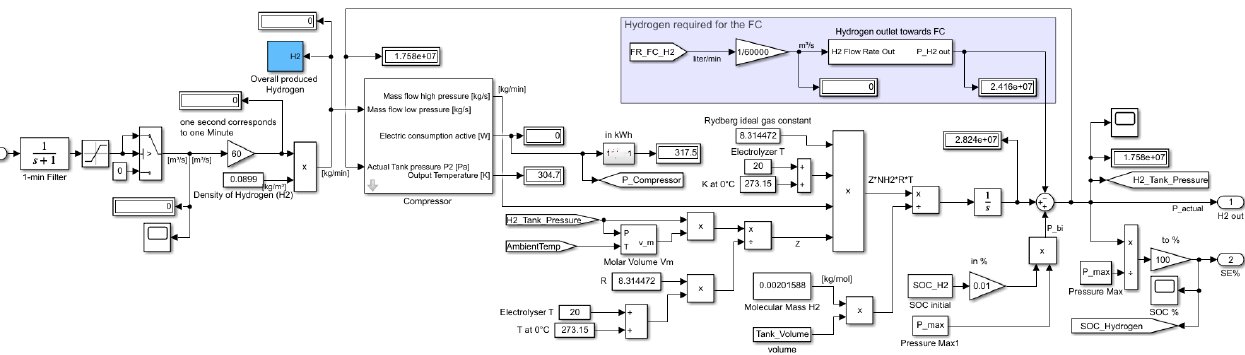
Figure 8 . Simulink model of hydrogen storage including a compressor (own figure based on